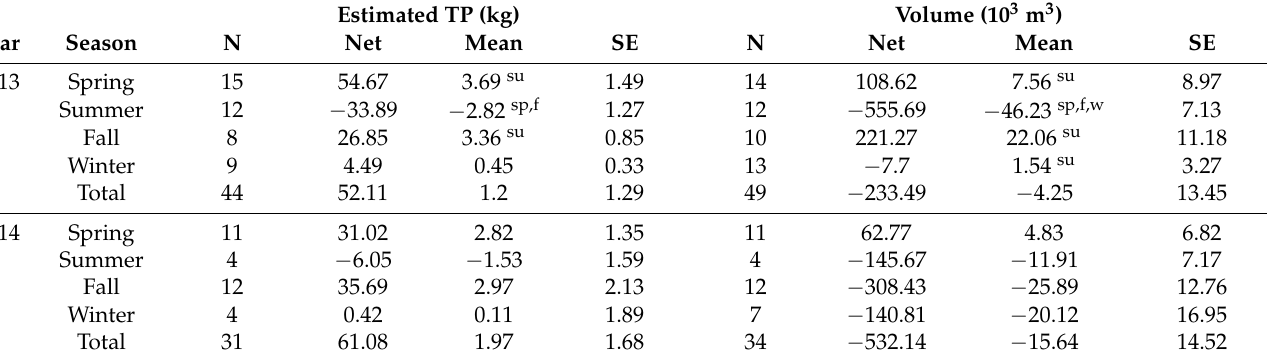
Table 1. Number of weeks sampled (n), Net (difference between inflow and outflow), weekly sea- sonal mean, and standard error of the mean (SE) for estimated total phosphorus (TP, kg) and water volume (×10 3 m 3 ) fluxes, for the four seasons (see text for description) at the Pool 2B wetland, Ottawa